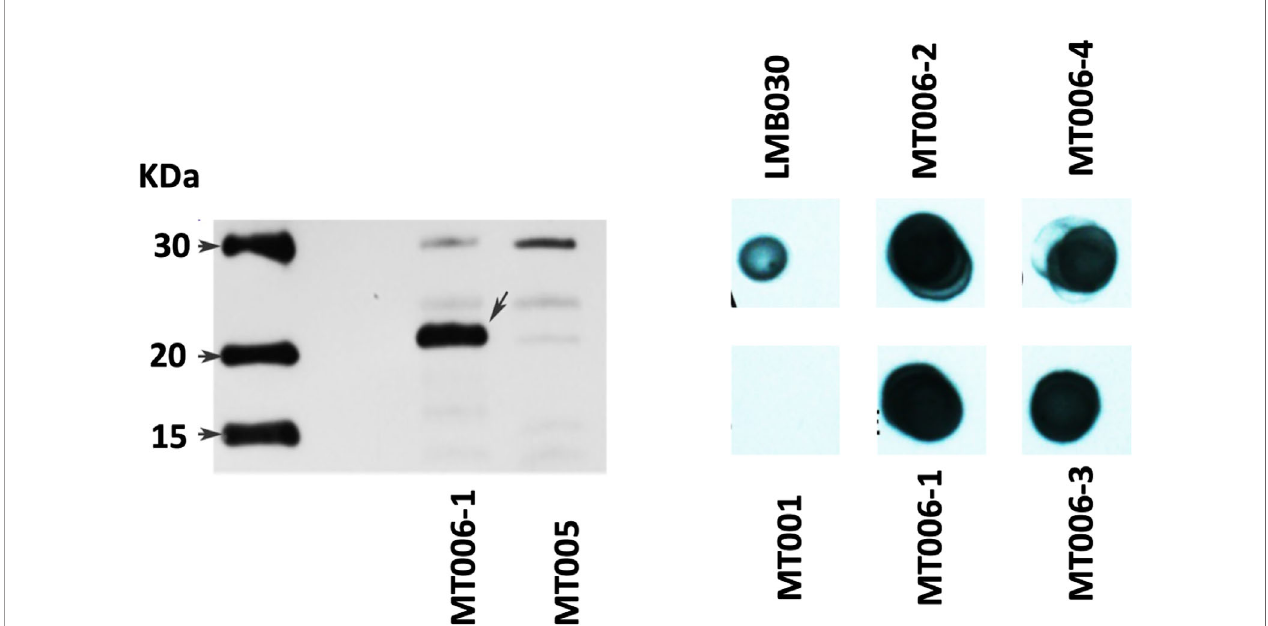
FIGURE 2 | Expression of recombinant IFN-Ia in L. lactis NZ3900. On the left panel, the fi gure shows a western blot using cytoplasmic extracts of cultures of the strain MT006 ( L. lactis NZ3900 + prIFNIa), and MT005 ( L. lactis NZ3900 + pNZ8149). The arrow points to the recombinant interferon Ia (rIFN-Ia) in lane of MT006. The right panel shows a dot blot of protein extracts of the supernatants of the used cultures obtained by precipitation with TCA and levosucranase in the dot loaded with the extracts obtained from strain